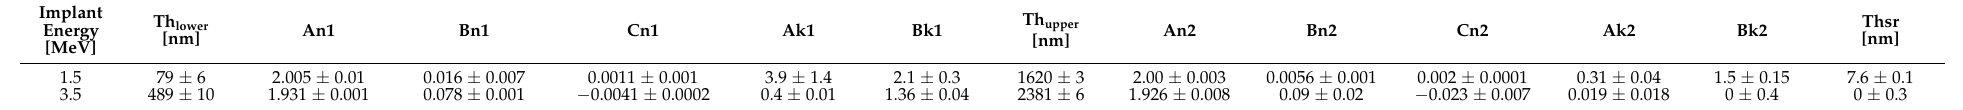
Table 1. Optical parameters from the SE